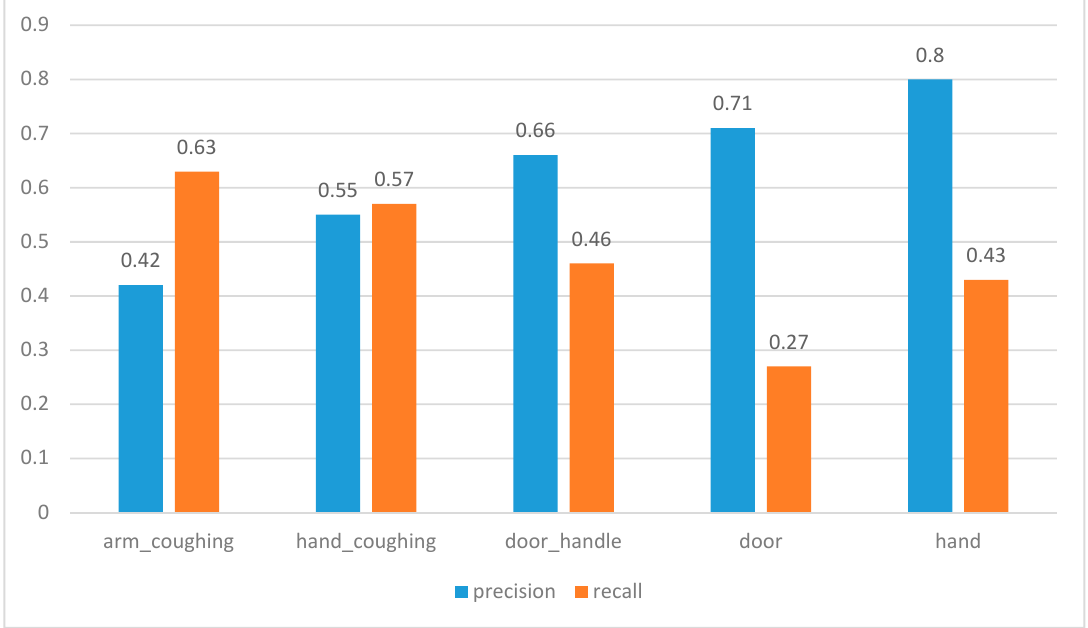
Figure 8. Object detection results of Masked regional convolutional neural network ( Mask-RCNN) architecture.